Question: Draft a figure caption describing what is shown.
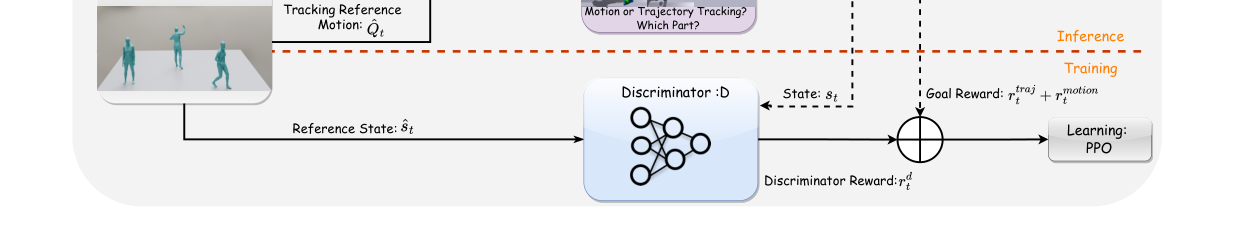
Answer: Framework of PACER+. Our framework follows the goal-conditioned reinforcement learning with Adversarial Motion Prior. To enable fine-grained control of specific body parts, we introduce an additional spatial-temporal mask to the motion-tracking task. This mask indicates the presence of a reference motion that the policy should track. By focusing on this tracking task, our framework enables the demonstration of diverse pedestrian behaviors at specific time steps and locations in a zero-shot manner.